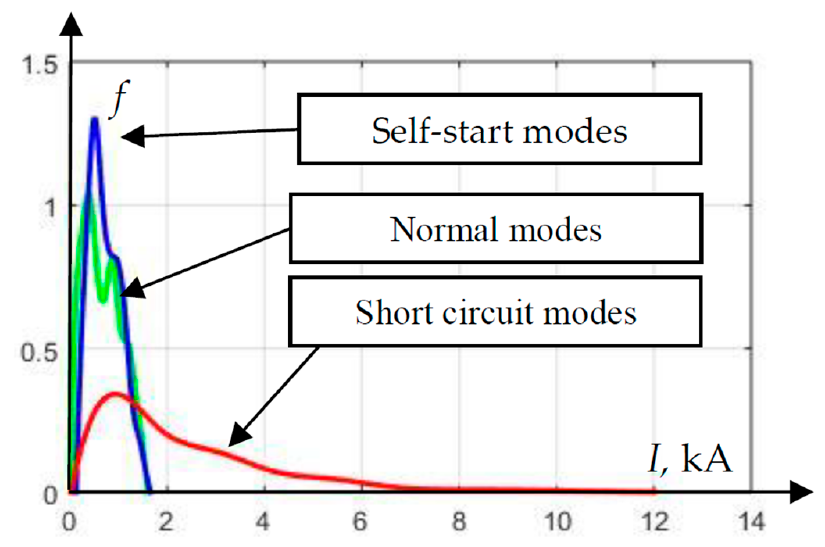
Figure 3. Current distribution of the analyzed phase in controlled modes.